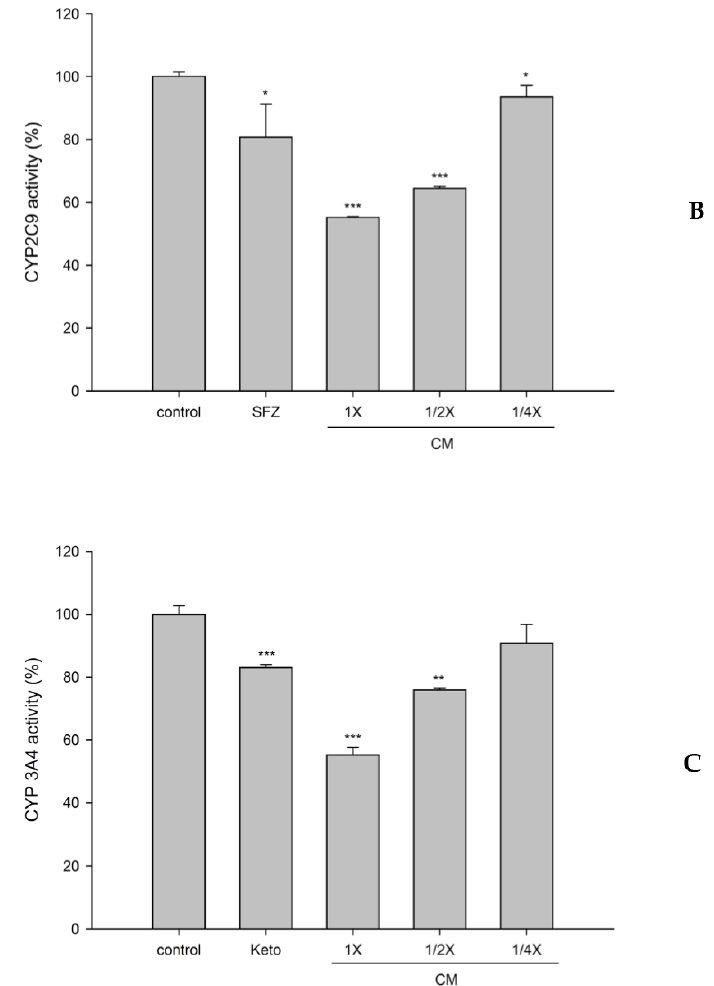
Figure 5. Effects of cranberry serum metabolites (CM; full, one half, and one quarter of the serum concentrations) on the activities of CYP1A2 ( A ), CYP2C9 ( B ), and CYP3A4 ( C ). * p < 0.05, ** p < 0.01, and *** p < 0.001. ANF ( α -naphthoflavone): a positive control for the CYP1A2 inhibitor. SFZ (sulfaphenazole): a positive control for the CYP2C9 inhibitor. Keto (ketoconazole): a positive control for the CYP3A4 inhibitor.